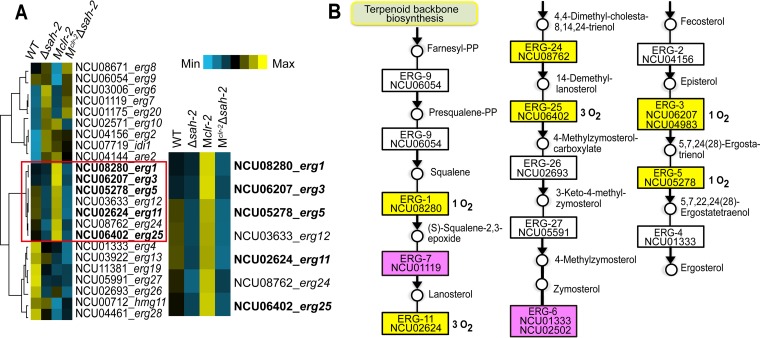
Influence of sah-2 on the expression of genes involved in the ergosterol biosynthesis pathway. (A) Hierarchical clustering of genes involved in ergosterol biosynthesis. Results are displayed as heat maps with log numbers of RPKM ranging from minimum (bright blue) to maximum (bright yellow). The SREBP direct targets, as identified in A. fumigatus (30), are shown in bold at the right. (B) Ergosterol biosynthesis pathway. The genes highlighted in yellow were those whose expression levels were downregulated both in the Δsah-2 mutant versus the WT and in the Mclr-2 Δsah-2 strain versus the Mclr-2 strain. The genes highlighted in pink were those whose expression levels were upregulated both in the Δsah-2 mutant versus the WT and in the Mclr-2 Δsah-2 strain versus the Mclr-2 strain. Oxygen-requiring enzymes are marked.